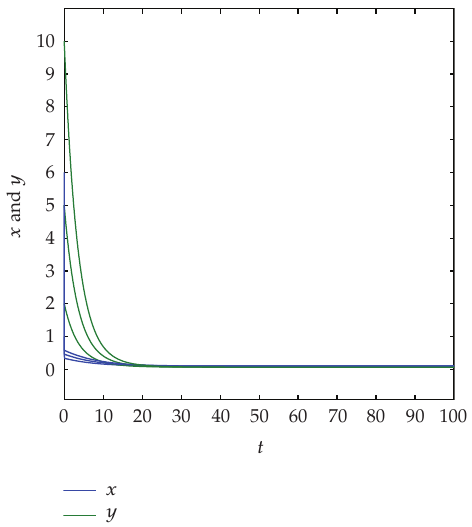
Figure 4: Solution curves of system (cid:6) 1.1 (cid:7) with the parameters given by Example 6.1 when r 1 (cid:8) 100.